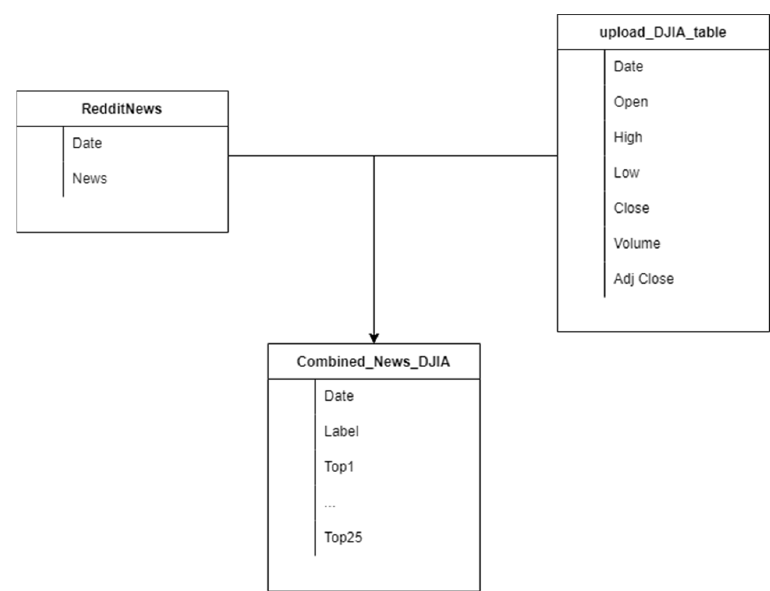
Figure 9. Training dataset.